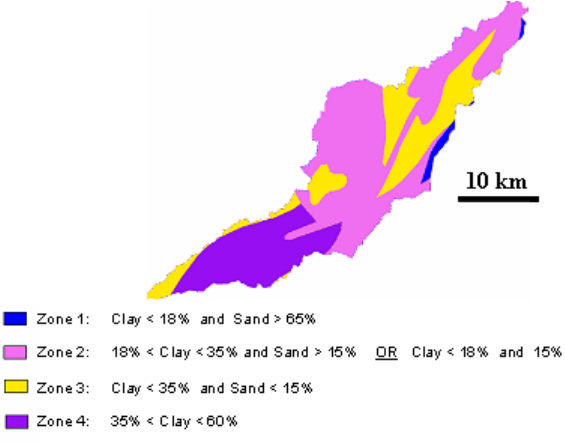
Figure 2. Soil textural zones of the Touch catchment defined according to the 1:1000000 Soil Geographical